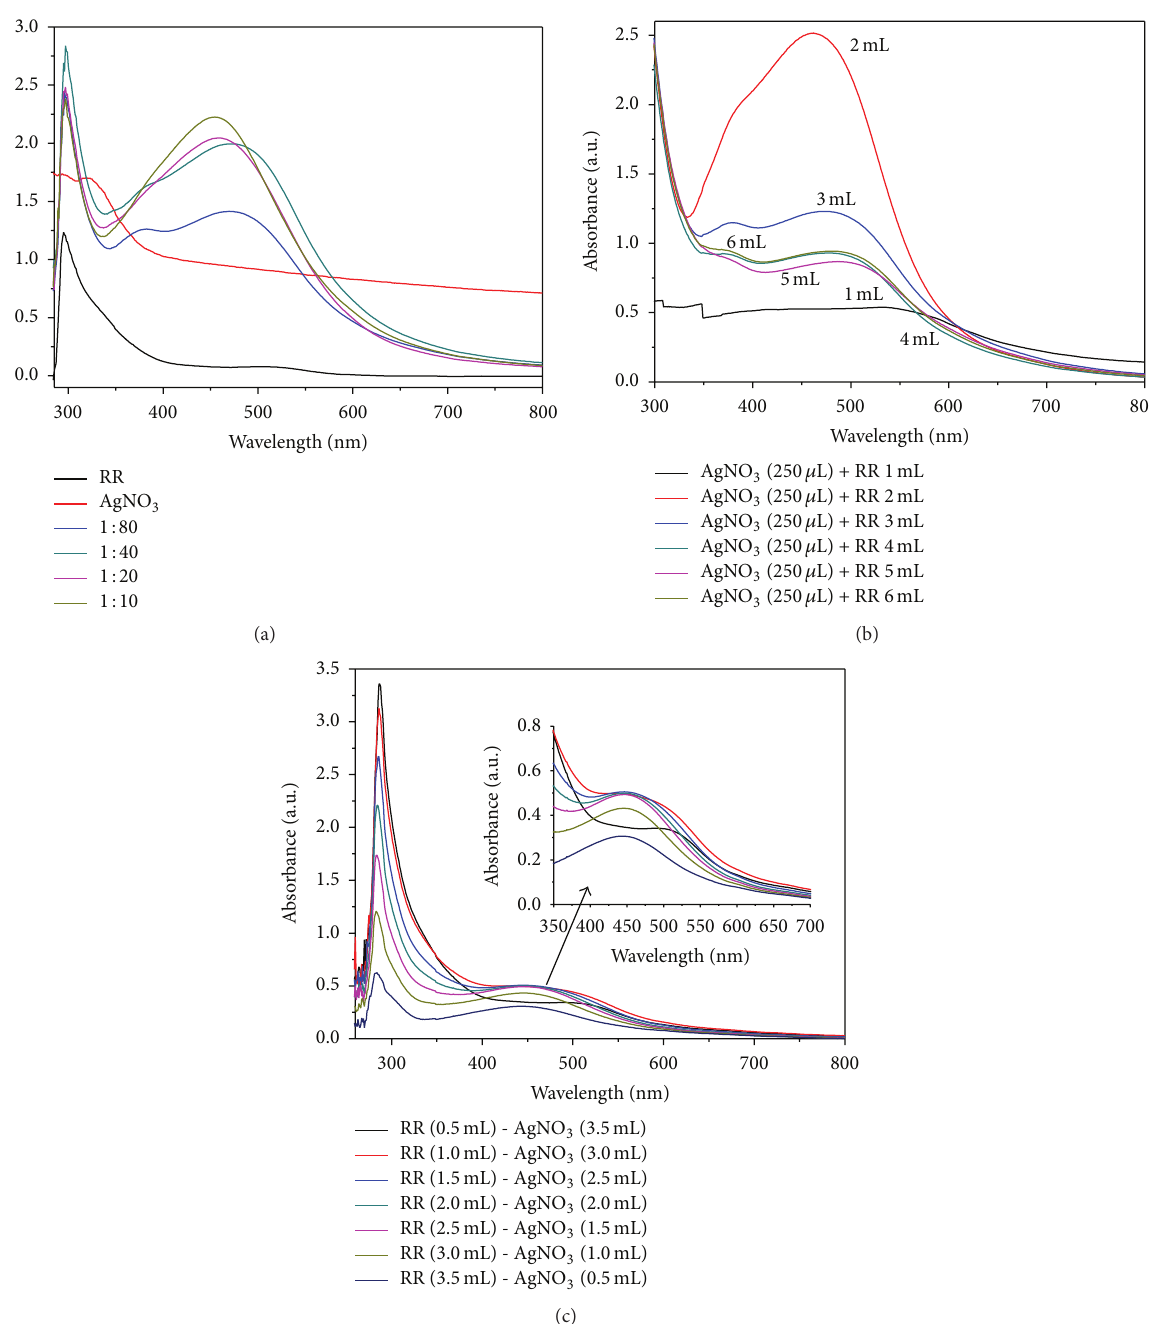
Figure 1: Variation of UV-visible spectra of RR-SNPs obtained using stem extract of Rheum rhabarbarum (RR) with (a) volume of AgNO 3 , (b) volume of RR, and (c) volume of both RR and AgNO 3